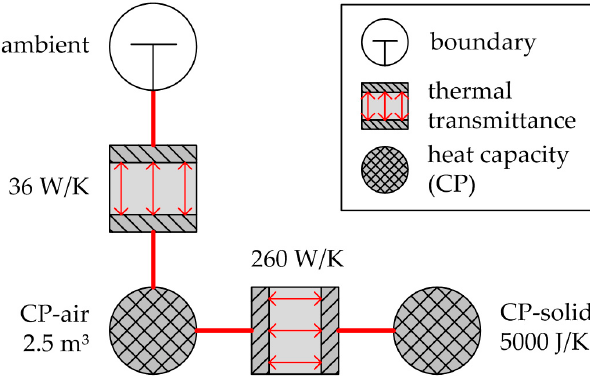
Figure 7. Schematic overview of the thermal cabin model.